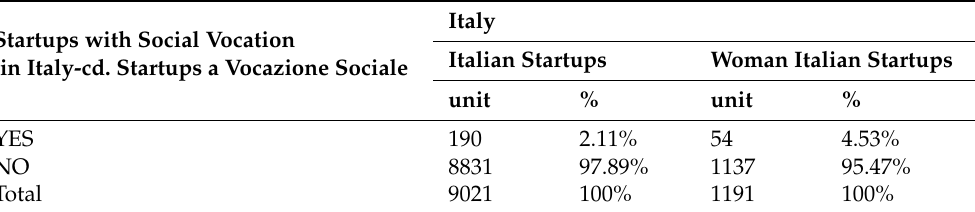
Table 15. Italian startups and Italian woman startups with social vocation. Startups with Social